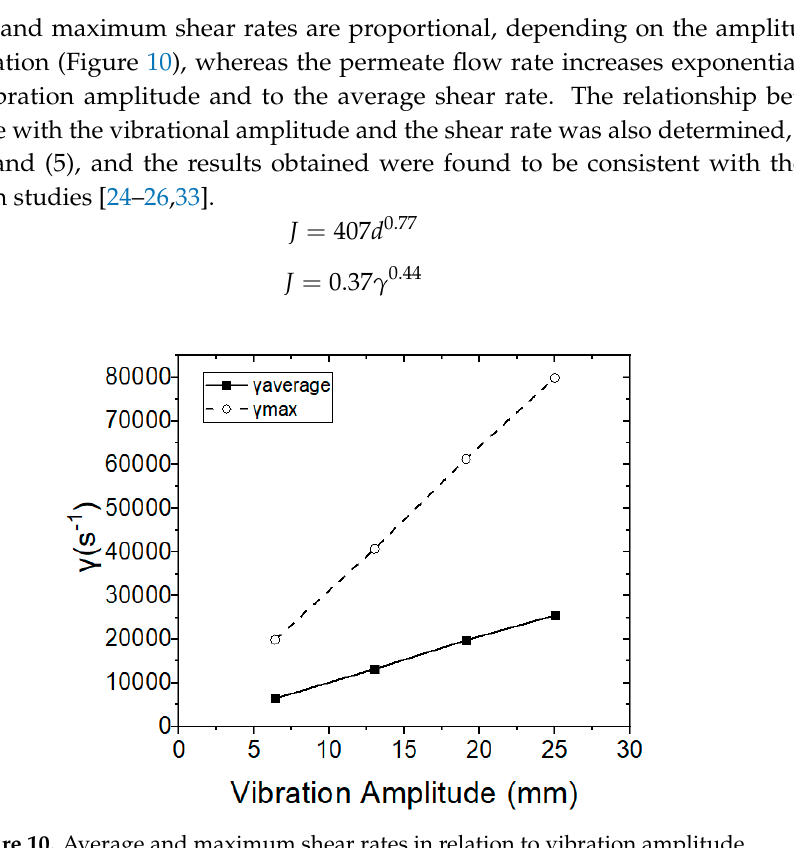
Figure 10. Average and maximum shear rates in relation to vibration amplitude.